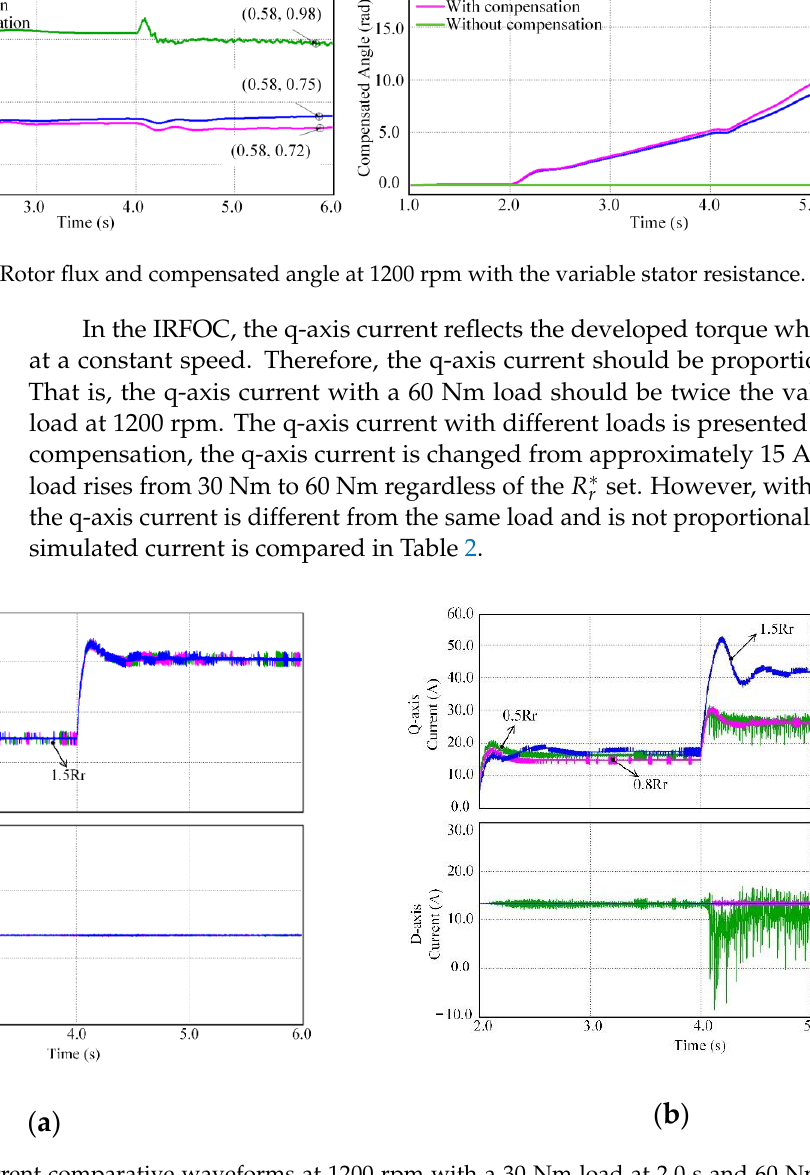
Figure 7. The q-axis current comparative waveforms at 1200 rpm with a 30 Nm load at 2.0 s and 60 Nm load at 4.0 s. ( a ) Current with compensation; ( b ) Current without compensation. Table 2. Q-axis current comparison. Without